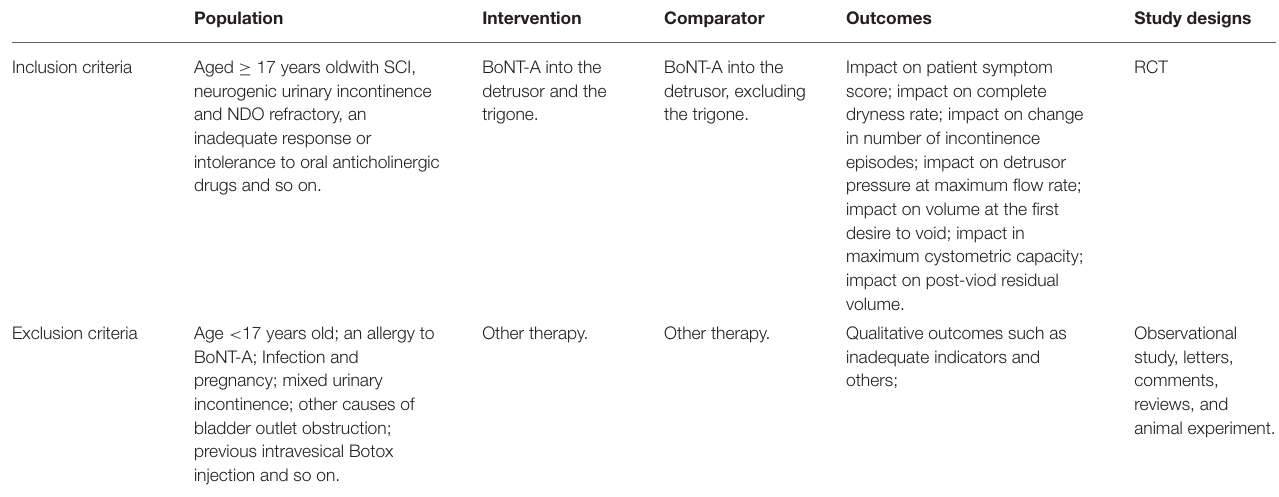
TABLE 2 | Criteria for considering studies for the review based on the population, intervention, comparator, outcomes, and study designs (PICOS) structure. Population